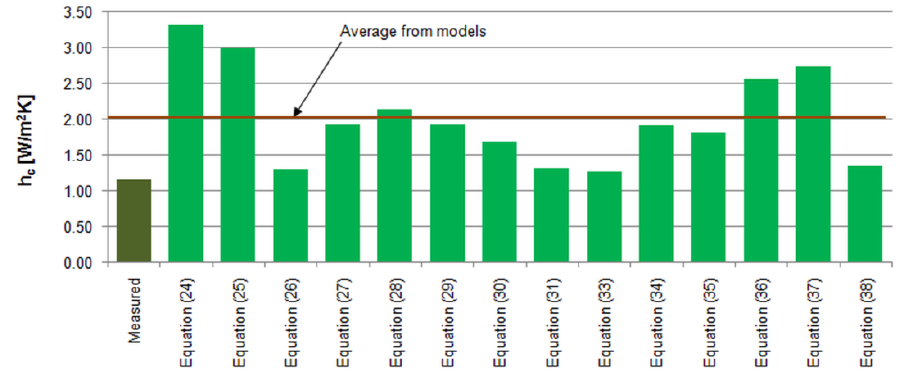
Figure 10. Average CHTCfor different models for measurement conditions.